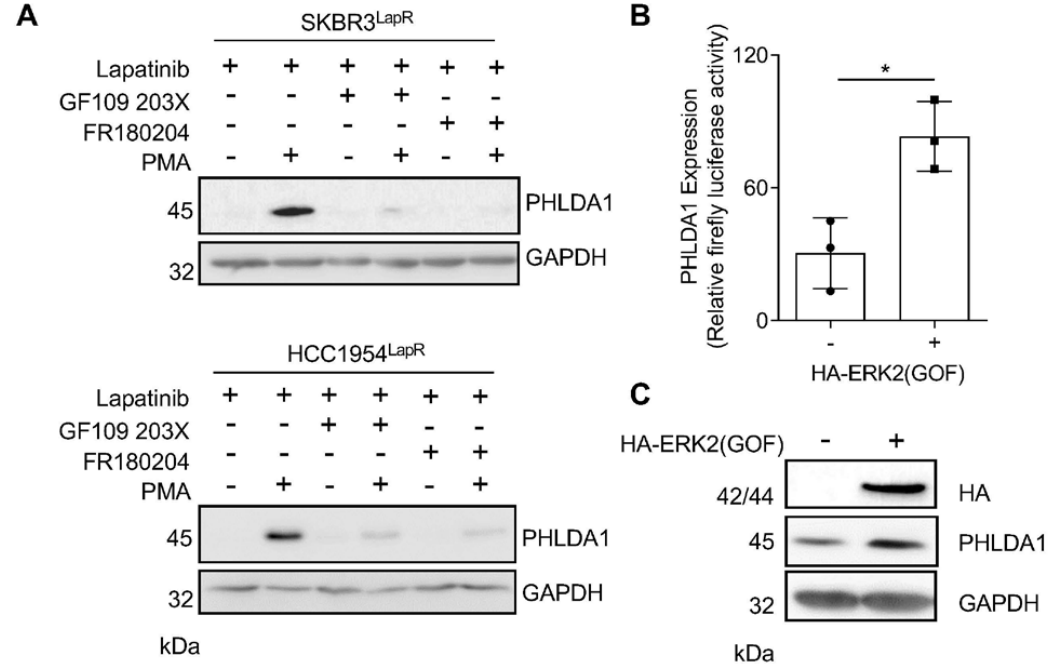
Figure 2. PHLDA1 transcription is regulated by PKC and ERK1/2. ( A ) Western blot analysis of PHLDA1 expression in lapatinib-resistant SKBR3 and HCC1954 cells (SKBR3 LapR and HCC154 LapR ) cultured in 1 µ M lapatinib and treated for 48 h with 20 nM PMA in the presence and absence of 5 µ M GF109203X and 40 µM FR180204. ( B , C ) PHLDA1 expression measured by luciferase activity ( B ) and Western blot ( C ) in parental HCC1954 cells and HCC1954 cells expressing HA-ERK2 (GOF)